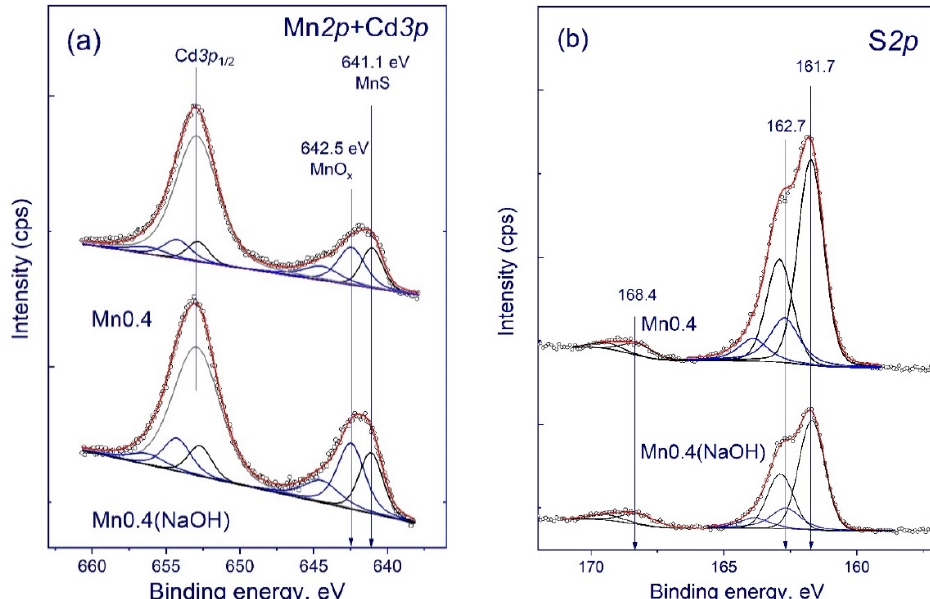
Figure 5. The Mn2p and Cd3p ( a ) and S2p ( b ) X-ray photoelectron spectroscopy (XPS) spectra of the photocatalysts Mn0.4(NaOH) and Mn0.4.